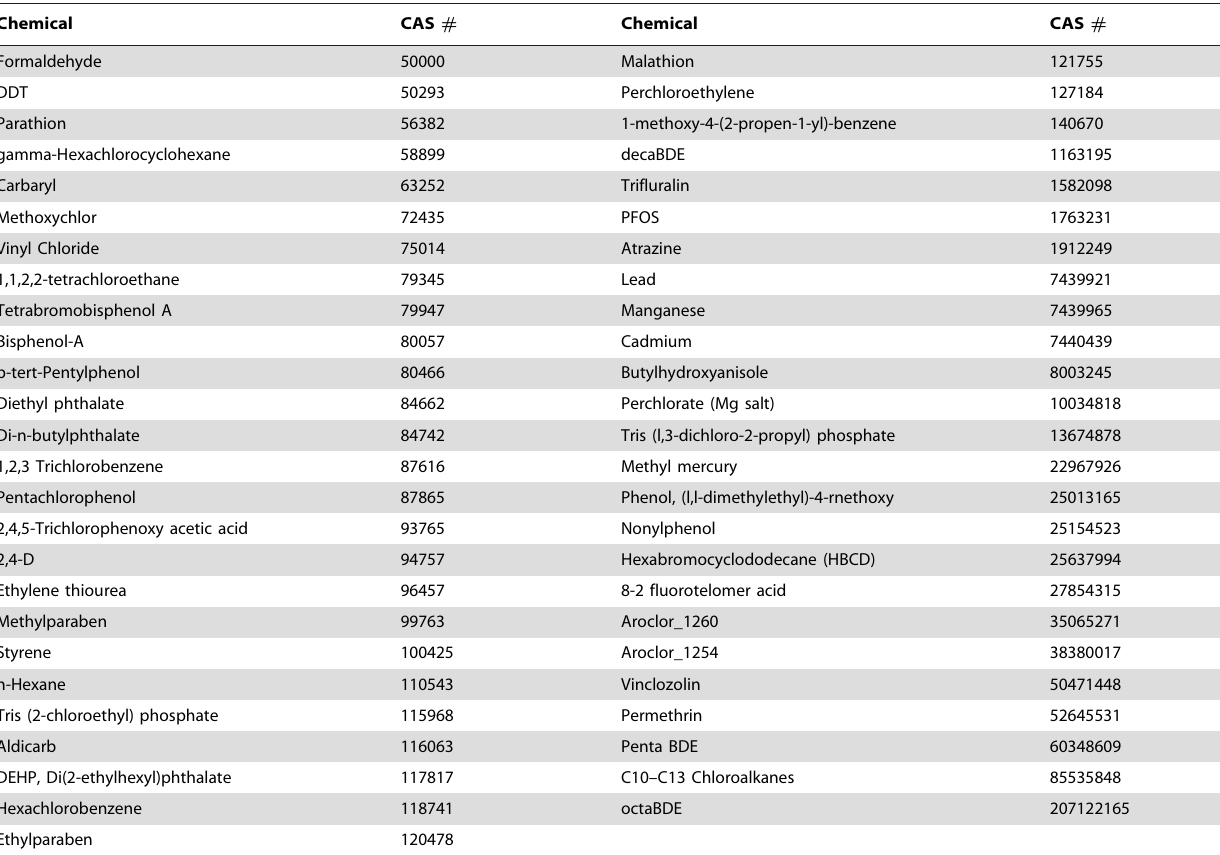
Table 2. Case Study